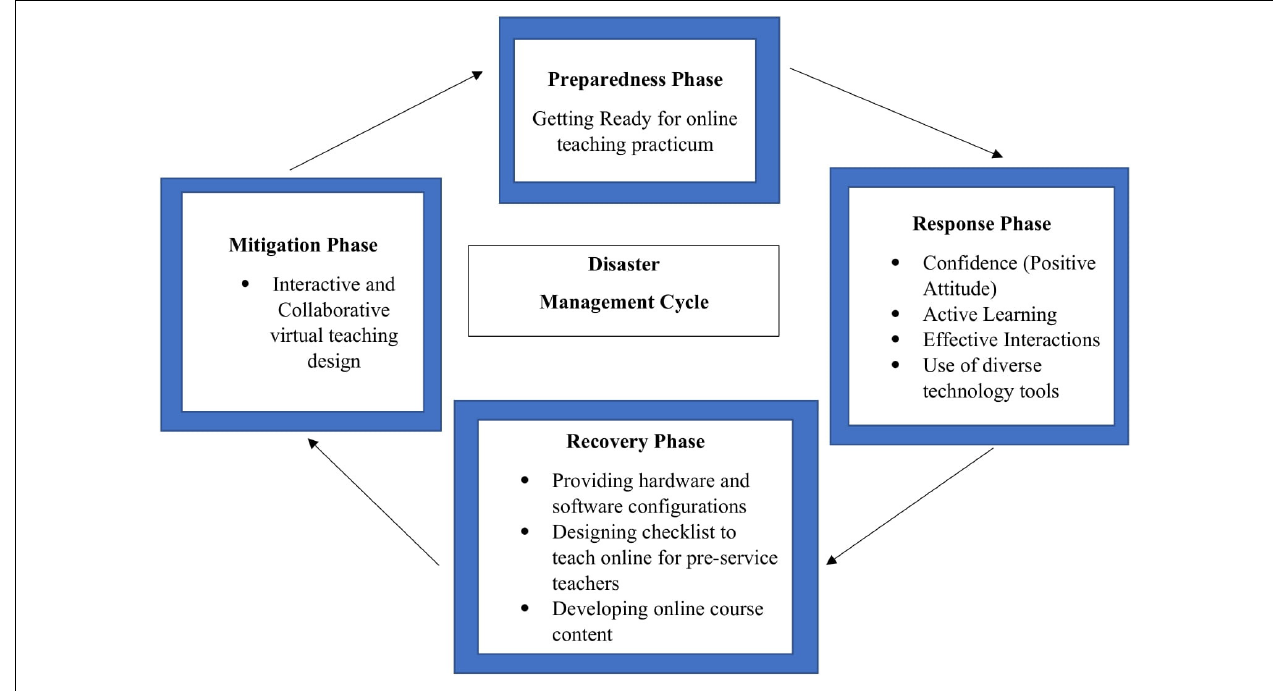
FIGURE 1 | Online teaching practicum based on the Disaster Management